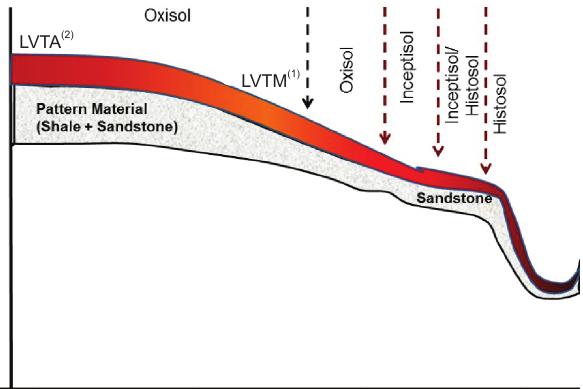
Figure 1. Topographic profile of the toposequence. (1) Typic Hapludox (Oxisol) with medium texture; (2) Typic Hapludox (Oxisol) with clay texture. Source: Ferreira et al. (2011).